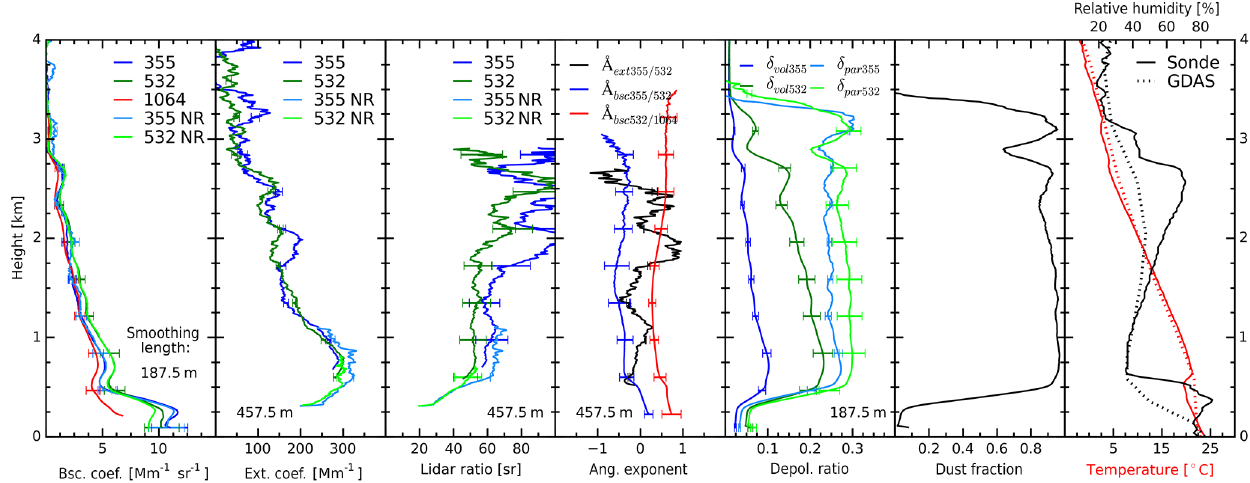
Figure 9. Profiles averaged for 11 November 2015, 19:30–21:00UTC. Dust fraction calculated following Tesche et al. (2009). Radio sound- ing profiles from 11 November 2015, 12:00UTC, and GDAS1 profiles (11 November 2015, 18:00UTC) are presented in the right